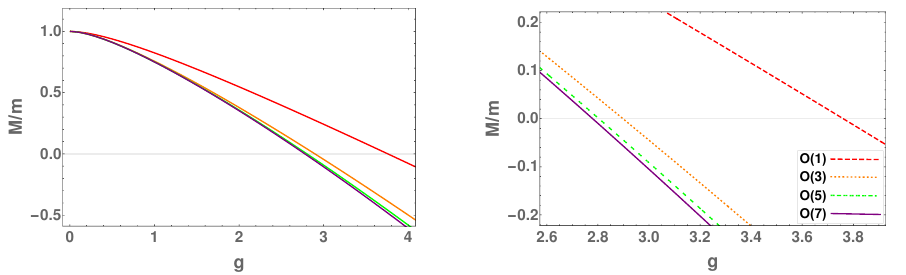
Figure 4 . Left panel: the physical mass, in units of m , as a function of g at odd orders. Right panel: same as the left panel but zoomed.